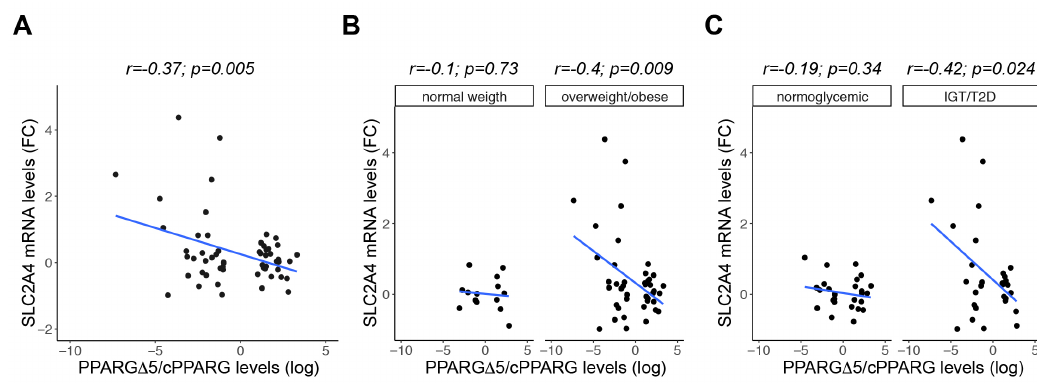
Figure 7. PPARG ∆ 5 / cPPARG ratio correlates with SLC2A4 levels. PPARG ∆ 5 and cPPARG expression was previously measured in Aprile et al. (2018). ( A – C ) Scatterplot reporting the correlations by linear regression analysis between SLC2A4 and PPARG ∆ 5 / cPPARG levels (qPCR) in the SAT of a subset of individuals ( n = 56), stratified in subgroups according to BMI in normal weight ( n = 14) and overweight / obese ( n = 42), or to glucose-metabolizing capacity in NGT ( n = 27), IGT and T2D ( n = 29). RPS23 was used as reference gene. Pearson’s correlation coe ffi cient (r) and p values ( p ) are